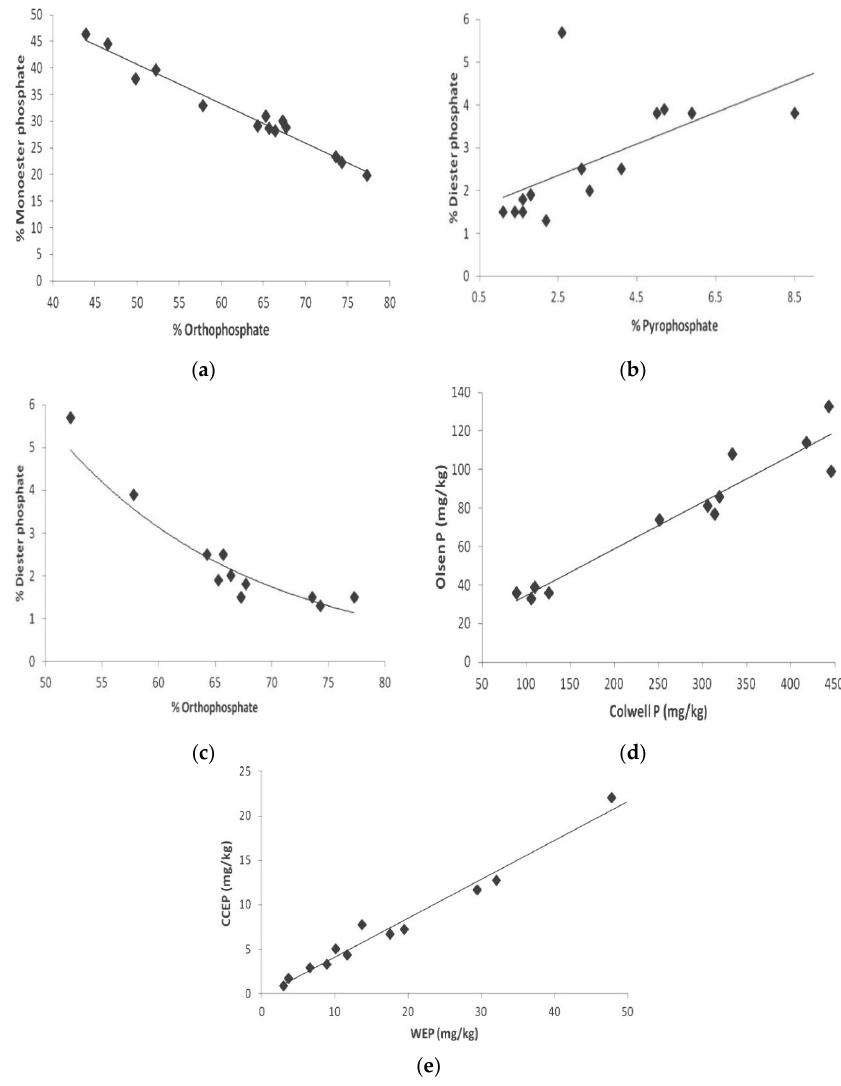
Figure 4. Selected scatter plots demonstrating correlation between: ( a ) monoester P and orthophosphate; ( b ) diester P and pyrophosphate; ( c ) diester P and orthophosphate; ( d ) Olsen P and Colwell P; ( e ) CCEP and WEP.